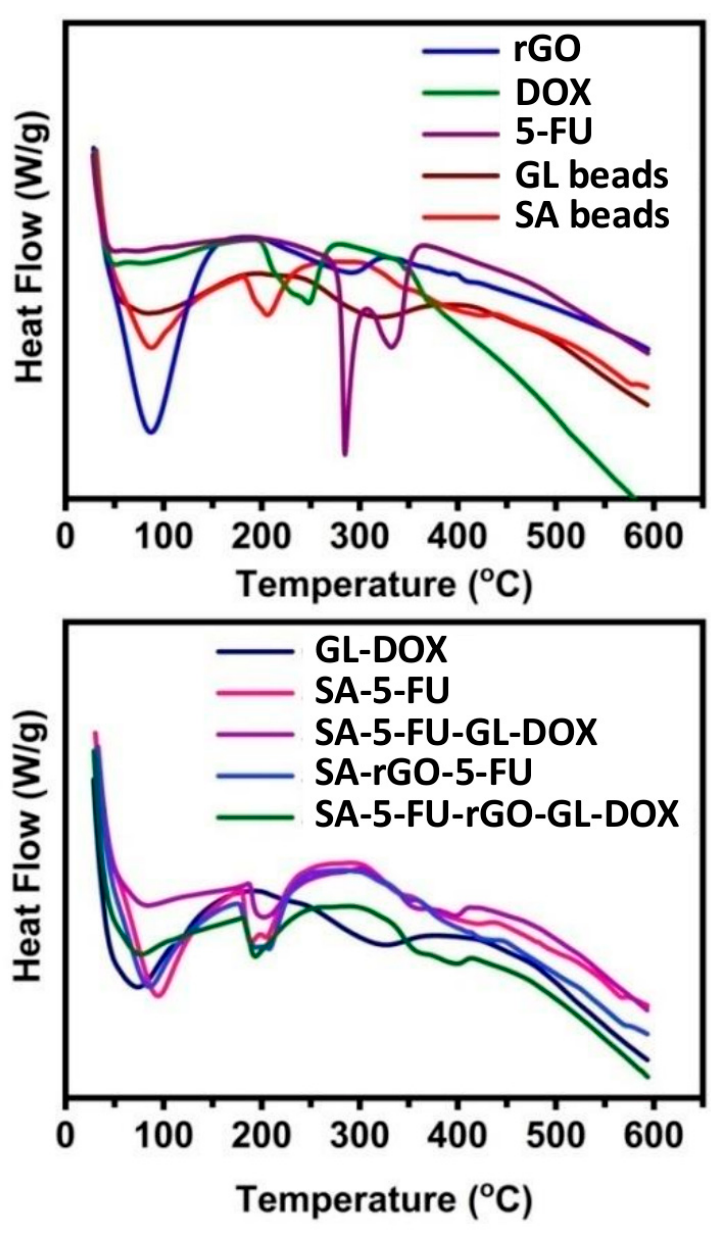
Figure 5. DSC curves of different beads (GL beads, SA beads, GL-DOX, SA-5-FU, SA-5-FU-GL-DOX, SA-rGO-5-FU and SA-5-FU-rGO-GL-DOX) and their constituents (rGO, DOX and 5-FU).